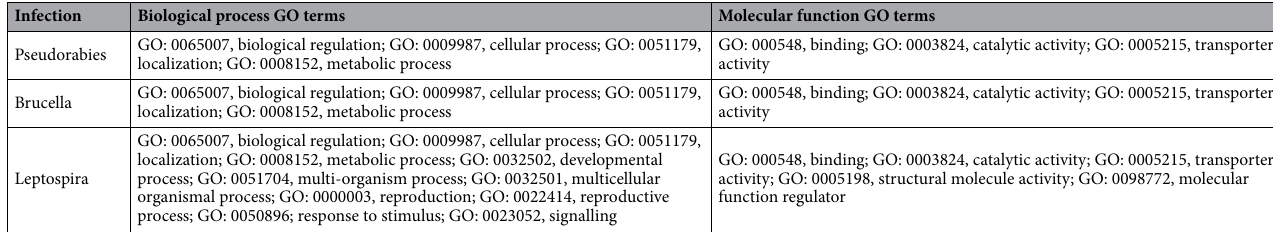
Table 3. Biological process and molecular function Gene Ontology (GO) terms enrichment analysis